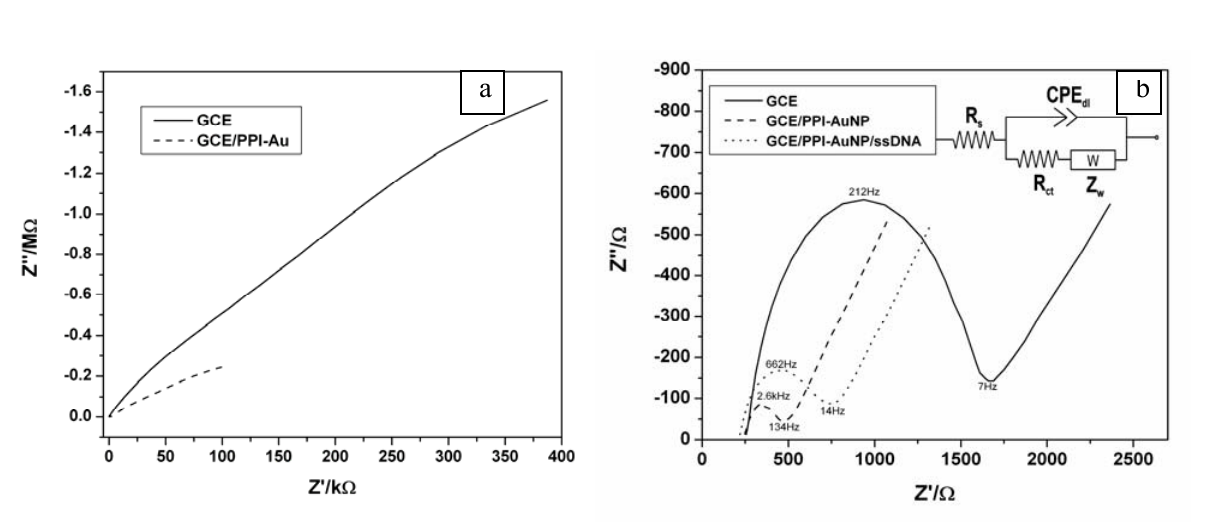
Figure 5. (a) Nyquist plot of bare GCE and GCE/PPI-AuNP in PBS. (b) Nyquist plot of